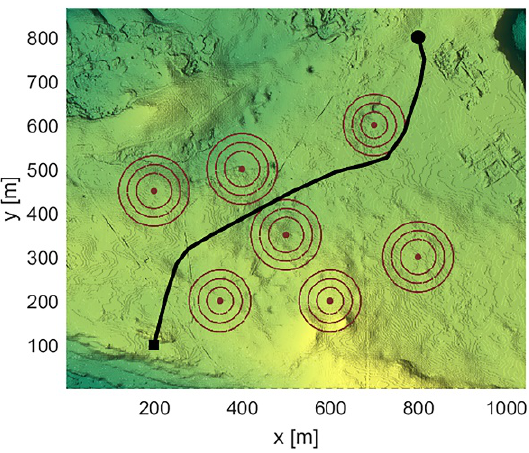
Figure 22. The top view of the path generated by the ninth group of data for the IC-VAINDIWPSO algorithm. Table 8 shows the data in Scenario 4 of Reference [21]. It can be seen from the data that the fitness function value and convergence algebra of the PSO algorithm are higher than the quantum-behaved PSO algorithm (QPSO), the genetic algorithm (GA), and dif- ferential evolution (ABC). From the data in Table 5, it can be considered that the fitness function cost and convergence algebra of the IC-VAINDIWPSO are much higher quality than the PSO algorithm. Although the environment of this paper and the literature [21] are different, they are each chosen from Christmas Island, Australia, so evaluating Tables 6 and 8 horizontally, it can be seen that the IC-VAINDIWPSO algorithm is higher than the QPSO algorithm, the GA algorithm, and the ABC algorithm, so the IC-VAINDIWPSO al- gorithm, a variant of the PSO algorithm, is very valuable for in-depth study. Table 8. Algorithm data comparison. Algorithm